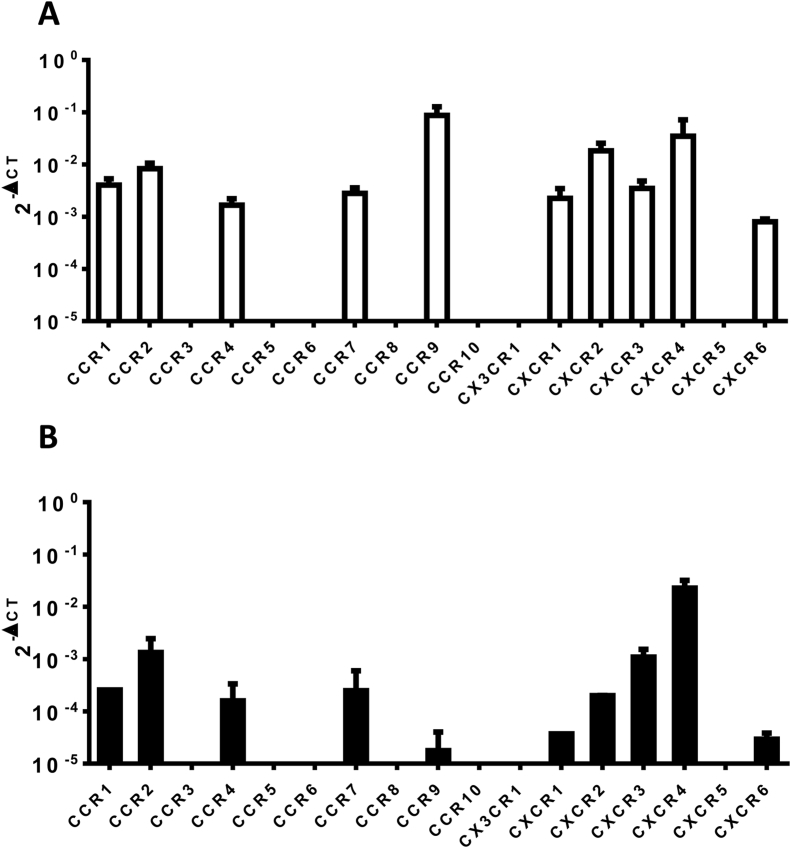
Chemokine receptor expression on KSL and HPC-7 cells. Gene expression of chemokine receptors in (A) freshly isolated KSL cells and (B) cultured HPC-7 cells was determined by quantitative polymerase chain reaction. Expression relative to glyceraldehyde-3-phosphate dehydrogenase by the 2-ΔCT method was determined. Bars represent means ± SEM expression in 3 independent experiments.